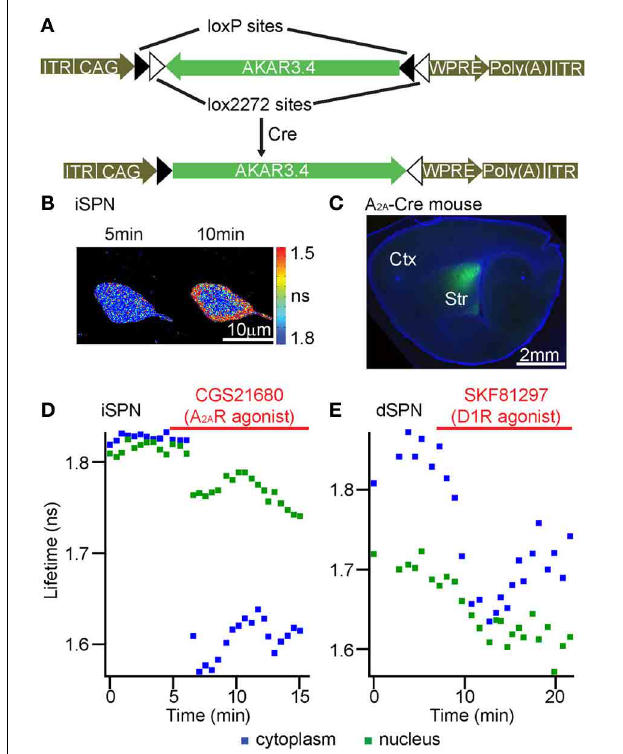
FIGURE 7 | FLIM-AKAR can be targeted to genetically defined cell types and reports modulation of PKA by endogenous GPCRs in the striatum. (A) AAV plasmid map showing how Cre recombinase leads to AKAR3.4 expression. (B–D) A Cre-dependent AAV virus carrying FLIM-AKAR was delivered to the striatum of an Adora2a BAC-Cre mouse. (B) Lifetime heat map of an indirect pathway striatal spiny projection neuron (iSPN) in an acute striatal slice. Following A 2A R activation by its agonist CGS21680, cytoplasmic FLIM-AKAR became rapidly phosphorylated, while nuclear FLIM-AKAR showed a slower response. (C) A parasagittal brain section showing FLIM-AKAR expression in the striatum. (D) Example plots showing modulation of PKA by A 2A R in an iSPN. 1 μ M CGS21680 was used to activate A 2A R. (E) A Cre-dependent AAV virus carrying FLIM-AKAR was delivered to the striatum of a Drd1 BAC-Cre mouse to target direct pathway SPNs (dSPNs). Example plots showing modulation of PKA by SKF81297 in a dSPN. 1 μ M SKF81297 was used to activate